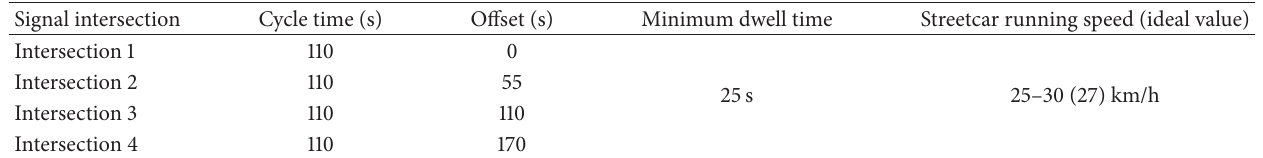
Table 2: Signal progression parameters based on the proposed